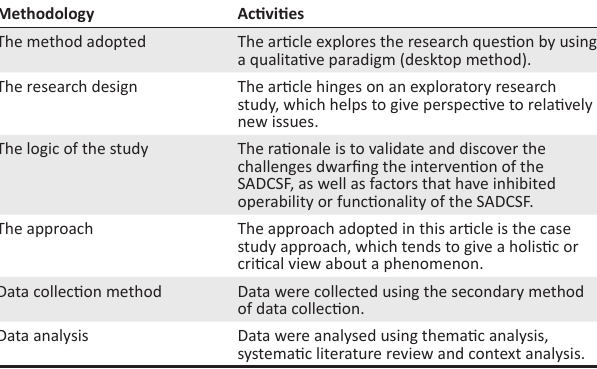
TABLE 1: Summary of proposed